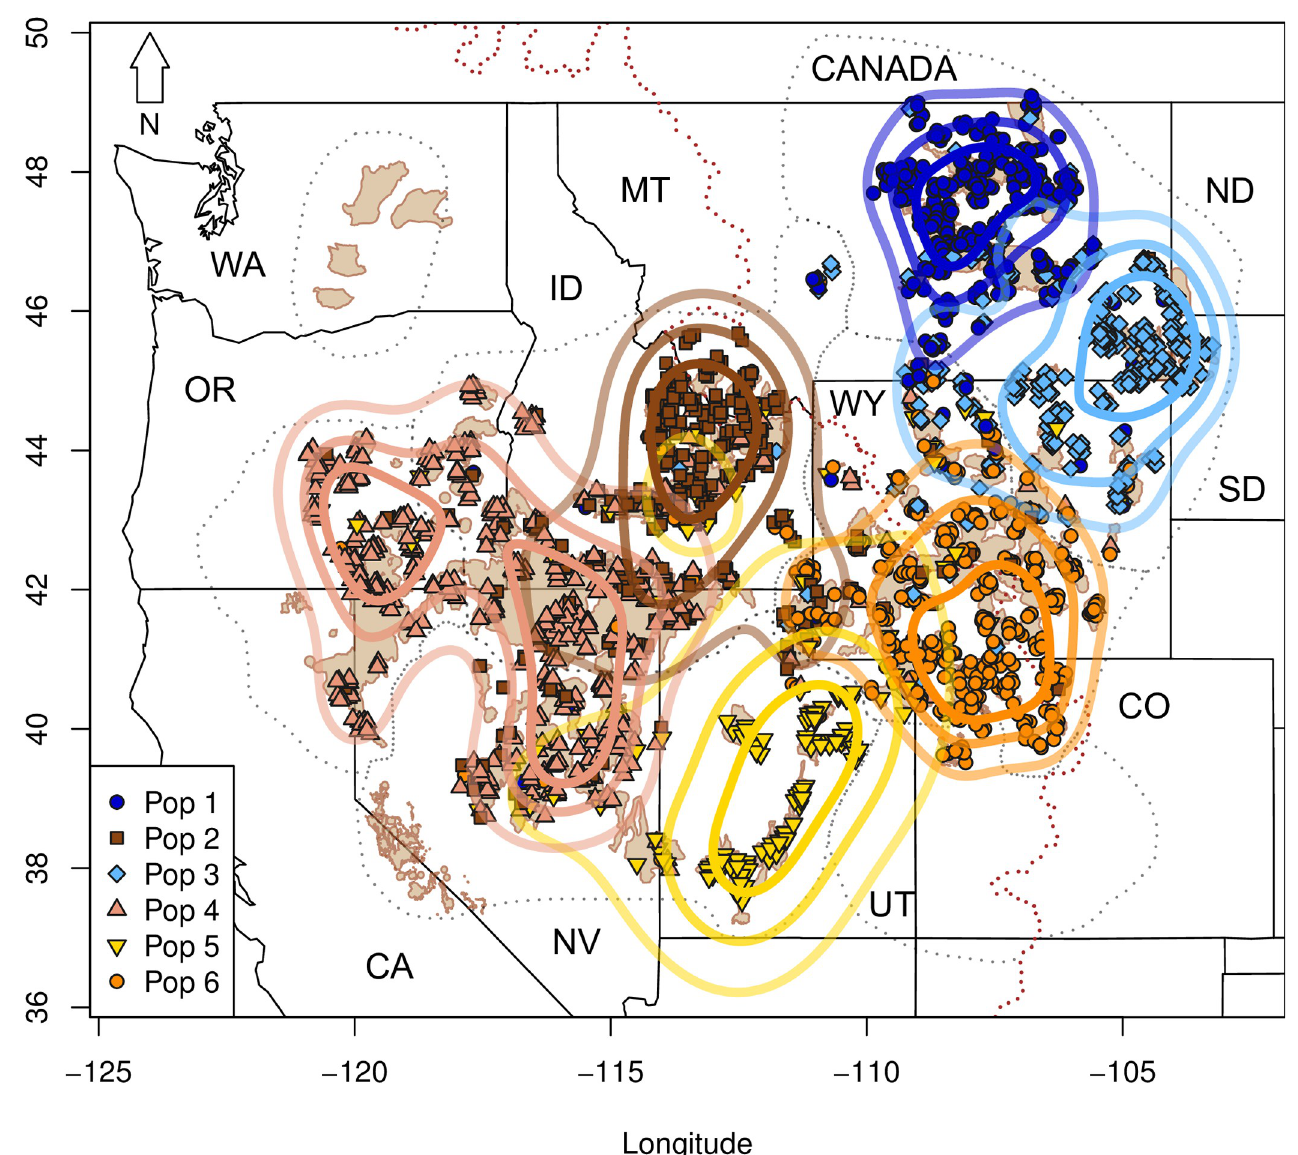
Fig 3. Boundaries of Greater Sage-grouse subpopulation centers at K = 6 from a STRUCTURE analysis using a 25% (darkest polygon), 50% (medium polygon), and 75% (lightest polygon) kernel density estimate to determine genetically distinct groups. The six different colors represent the six clusters identified in the STRUCTURE analysis. The dotted red line represents the Continental Divide. Tan polygons represent Priority Areas for Conservation and dotted black lines represent the seven sage-grouse management zones (MZ). State names are represented by the following abbreviations California (CA), Colorado (CO), Idaho (ID), Montana (MT), Nevada (NV), North Dakota (ND), Oregon (OR), South Dakota (SD), Utah (UT), Washington (WA), and Wyoming (WY).